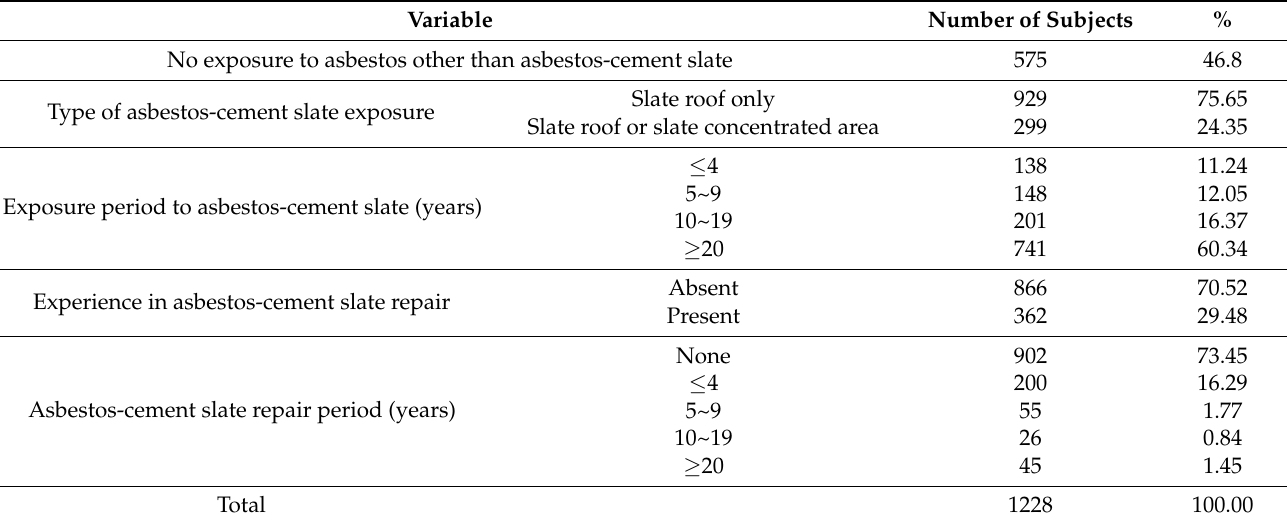
Table 3. The characteristics of the asbestos-cement slate-exposed